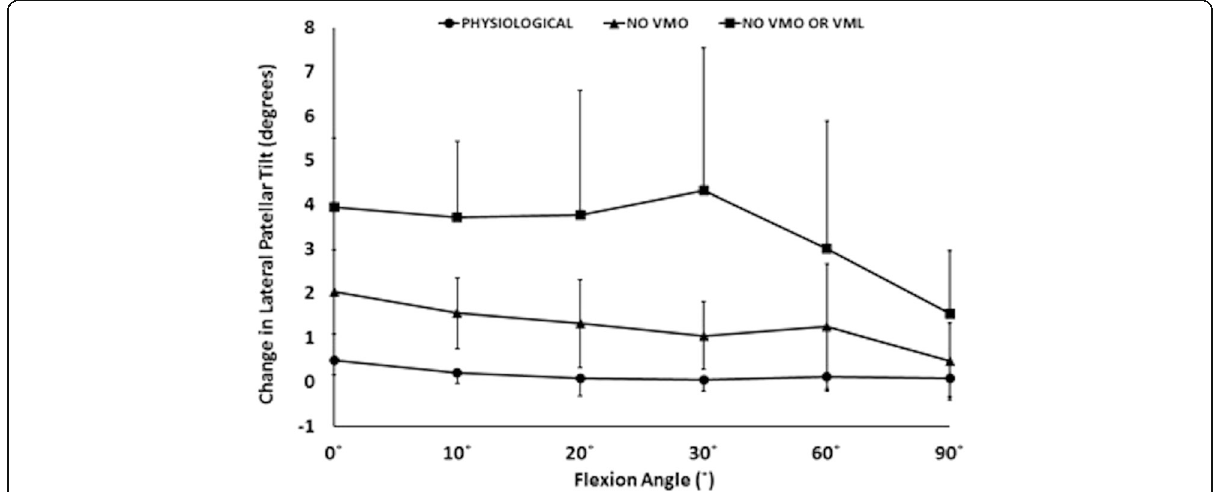
Fig. 8 Change of patellar lateral tilt in response to a 10 N lateral displacing force, showing increased effect when the VMM had been